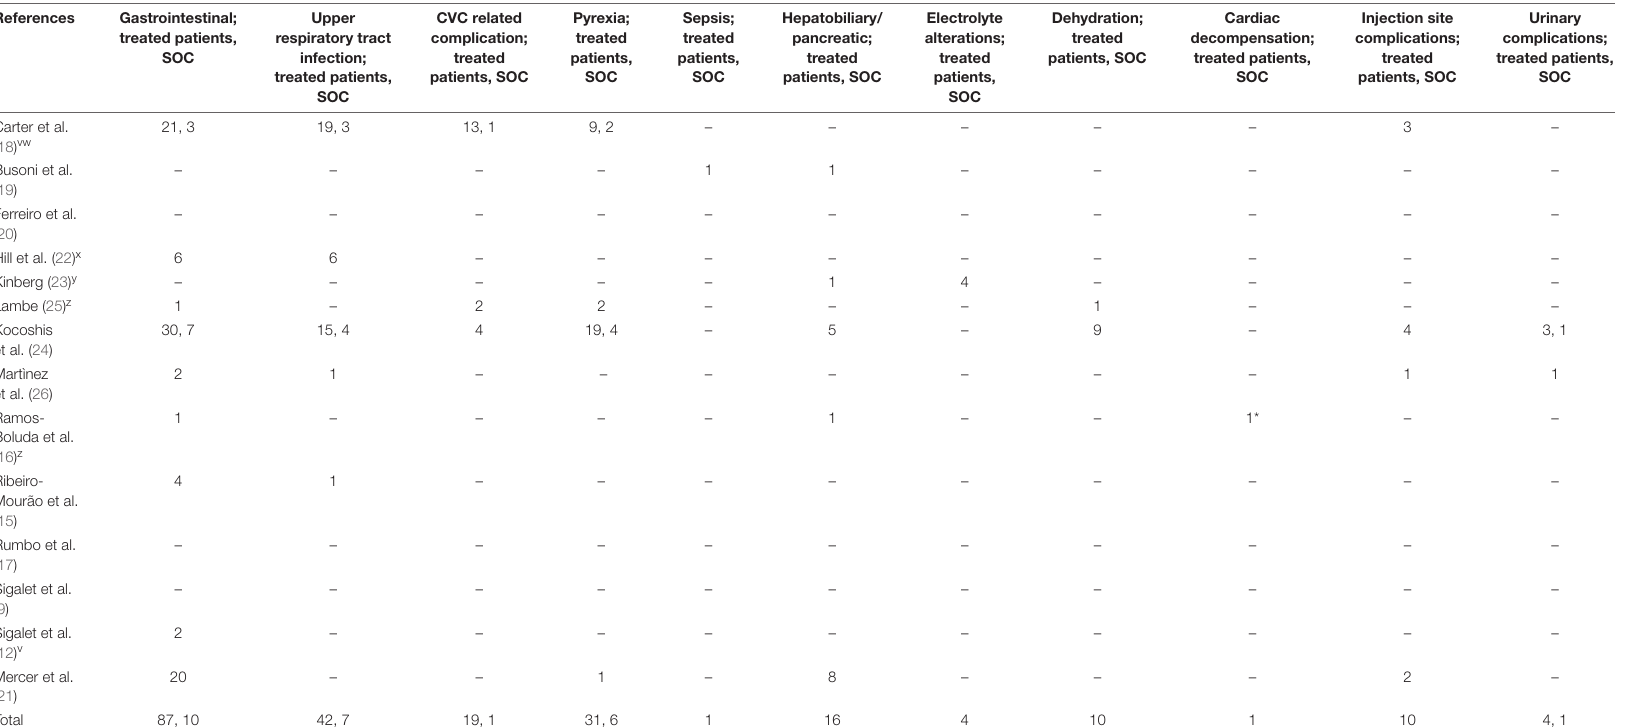
TABLE 6 | Adverse events emerged during treatment period; different complications may have developed in the same patient.